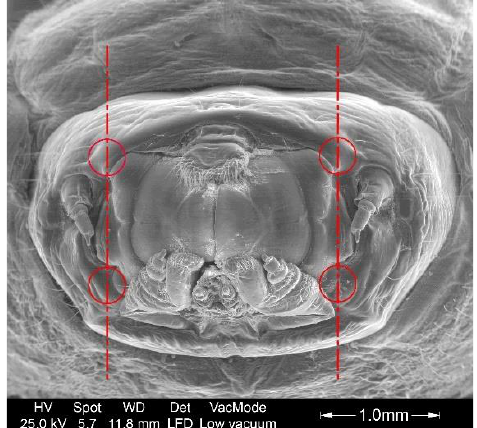
Figure 10. Mandibular joints and axes of rotation locations.